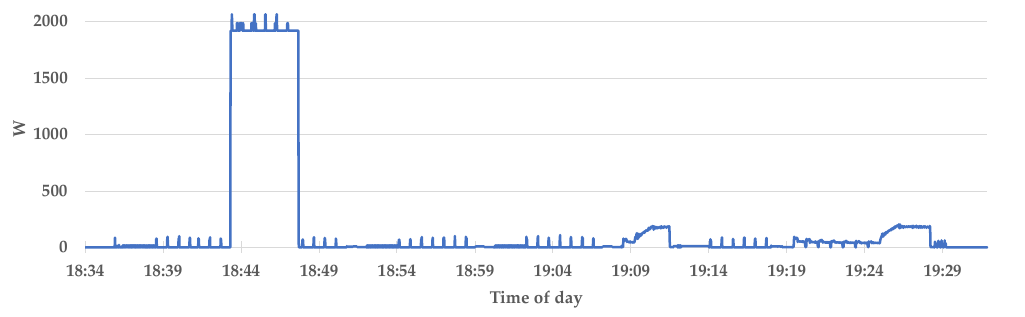
Figure 17. Load profile of the washing machine for a wool cycle (54 min).